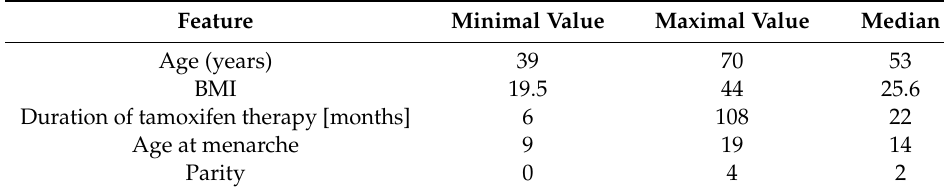
Table 1. Characteristics of studied